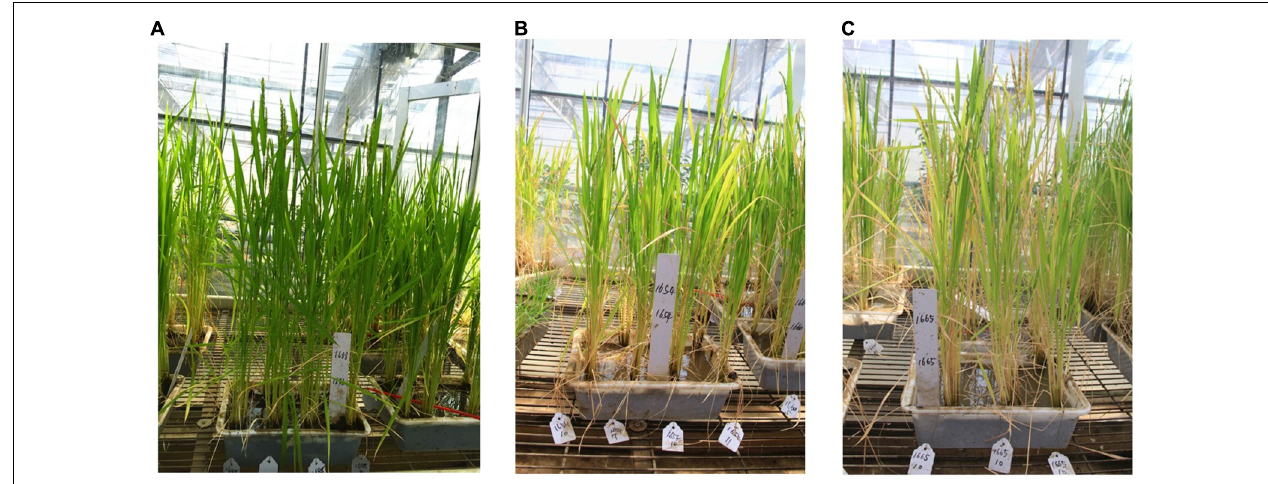
FIGURE 6 | Comparison of the growth among 1688, 1654, and 1665. (A) Growth status of 1688 after 30 days of artificial infestation. (B) Growth status of 1654 after 30 days of artificial infestation. (C) Growth status of 1665 after 30 days by artificial infestation. (Method: a third instar larva of striped stem borer was placed onto the stem of rice when the rice seedlings had grown to the tillering stage. When half of the larva body had drilled into a stem of rice, a label that marked the time and tillering was tagged on the stem. After 24 h of this artificial infestation, the leaf sheath in which the tiller with larva was located was split gently and the larva was removed. The plant was then packaged in silver paper and was subsequently frozen in liquid nitrogen and stored at − 80 ◦ C for later use. The plant without any artificial infestation was similarly sampled and